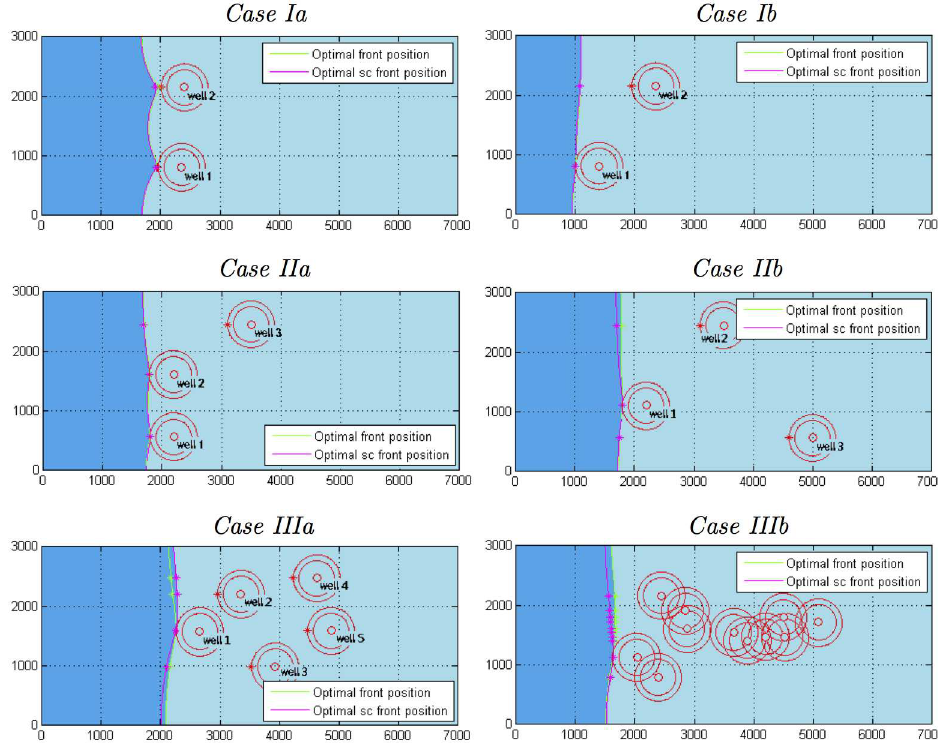
Fig 8. Optimal positions of the toe interface contour line for all simulation